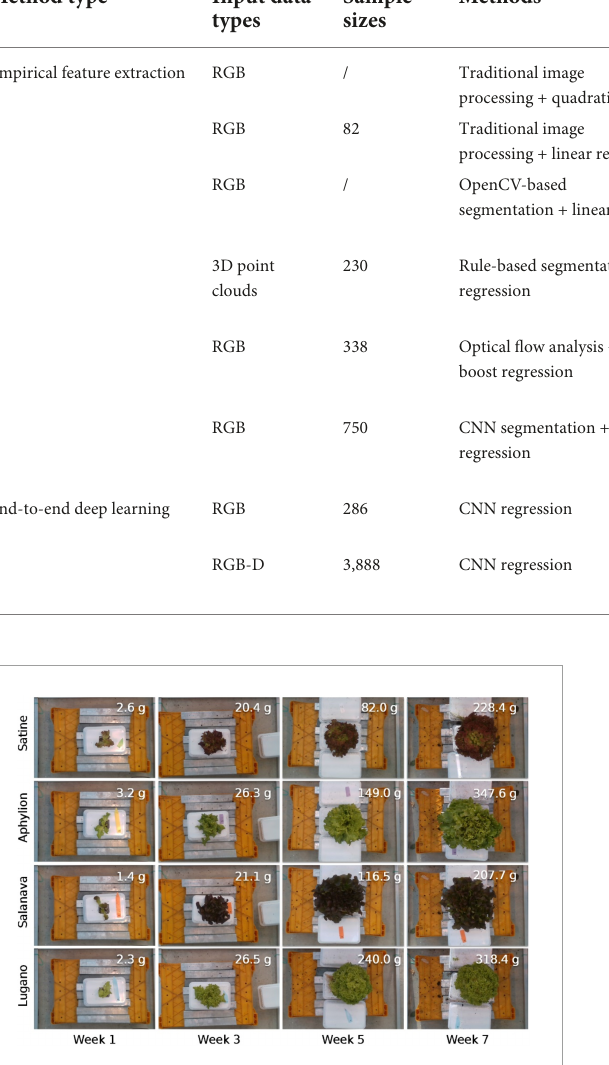
FIGURE1 Examples of RGB images (cropped) of the AGC dataset.